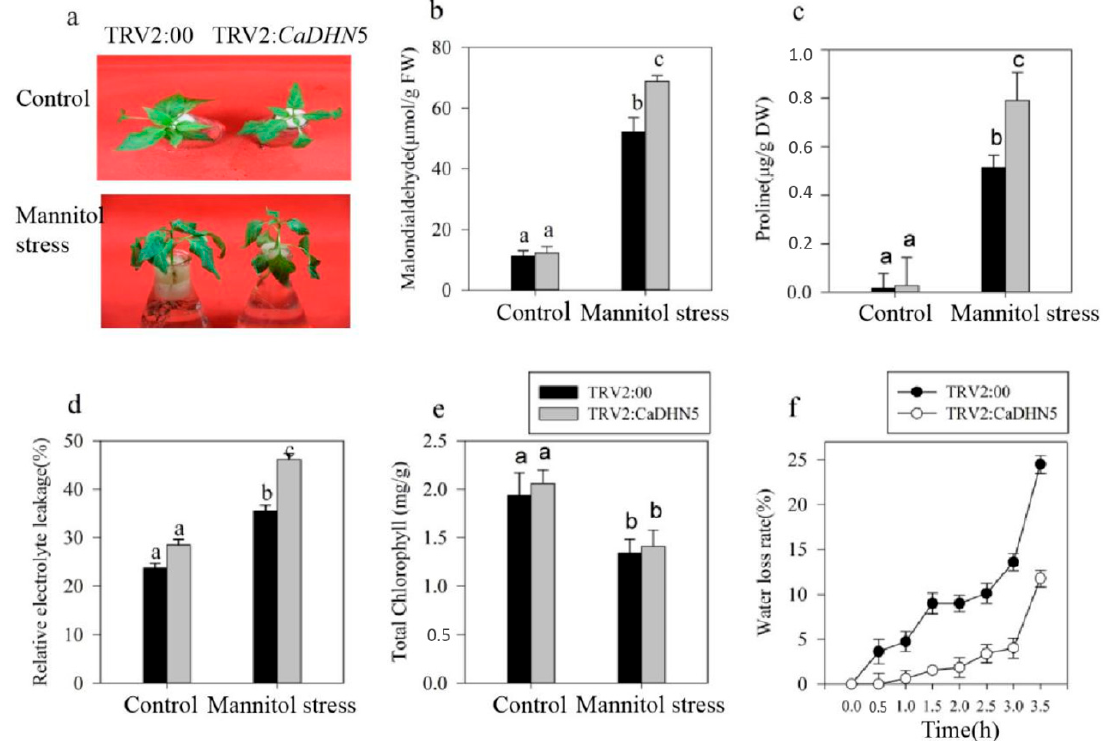
Figure 2. E ff ects of osmotic stress on plant phenotypes. ( a ) The phenotype of CaDHN5 -silenced pepper plants under osmotic stress; ( b ) MDA content; ( c ) proline levels; ( d ) relative electrolytic leakage; ( e ) total Chlorophyll content; ( f ) water loss. Data that are significantly di ff erent are indicated with letters above the error bars ( ± S.D.). The di ff erent letters with the bars indicate significant di ff erences as determined using Tukey HSD’s multiple range tests ( p < 0.05).